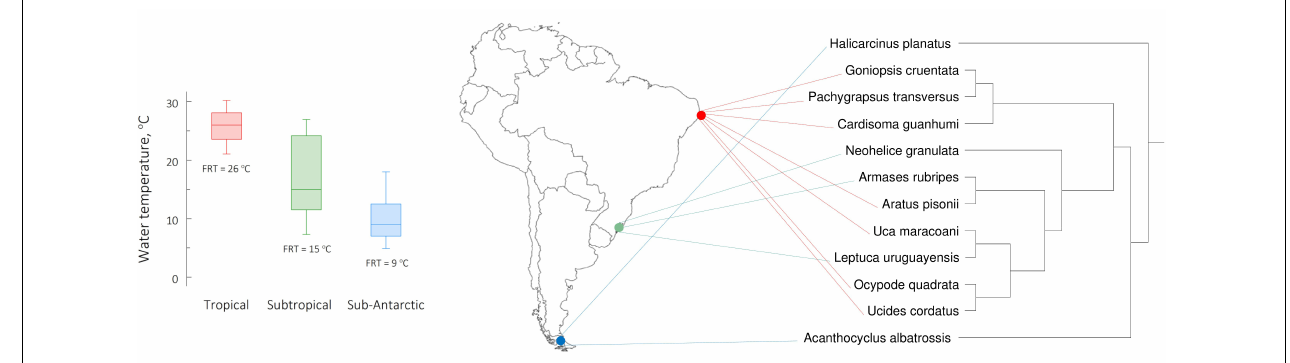
FIGURE 1 | Mean, monthly, maximum and minimum surface seawater temperatures registered between 2009 and 2019 (National Oceanic and Atmospheric Administration [NOAA] and U.S. Department of Commerce, 2019) ( left panel ) at the northern and southern geographical limits, respectively, of each zoogeographical province along the eastern Atlantic coast of South America ( sensu Boschi, 2000a). Surface seawater temperatures varied between 20.7 and 30.5 ◦ C for the Brazilian province, 7.0 and 27.5 ◦ C for the Argentinian province, and 4.0 and 18.0 ◦ C for the Magellanic province. The horizontal line within each box indicates the median temperature while the box boundaries show the interquartile values. Whiskers indicate the lowest and highest temperatures (range). Collecting site locations are indicated within each zoogeographical province ( middle panel ). The temperatures 26, 15, and 9 ◦ C represent the field reference temperatures (FRT) at which the crabs from each province were acclimated. The tropical species ( Aratus pisonii, Cardisoma guanhumi, Goniopsis cruentata, Ocypode quadrata , Pachygrapsus transversus, Uca maracoani, and Ucides cordatus ) were collected from the Brazilian province (northeastern Brazil, ≈ 7.8 ◦ S, 34.8 ◦ W, red). The subtropical species ( Armases rubripes, Neohelice granulata and Leptuca uruguayensis ) were collected from the Argentinian province (southern Brazil, ≈ 32.1 ◦ S, 52.1 ◦ W, green). The sub-Antarctic species ( Acanthocyclus albatrossis and Halicarcinus planatus ) were collected from the Magellanic province (southern Patagonia, ≈ 53.2 ◦ S, 67.2 ◦ W, blue). The phylogenetic relationships among the species investigated ( right panel ) were generated employing a maximum likelihood search method using the mitochondrial 16S ribosomal gene as a marker (see Faria et al.,